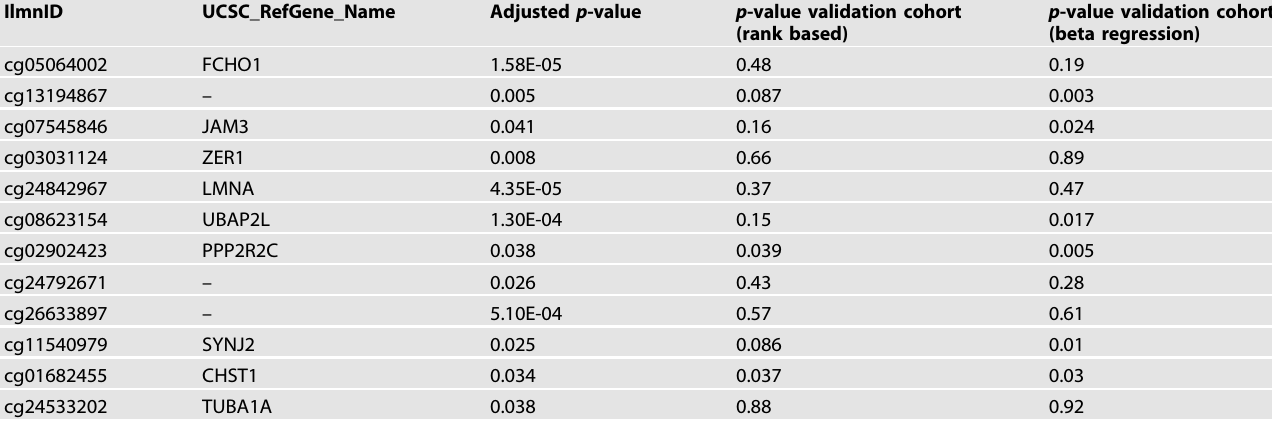
Table 2. Identi fi cation of novel epigenetic loci associated to AN and results of the exploratory analysis in the validation cohort.